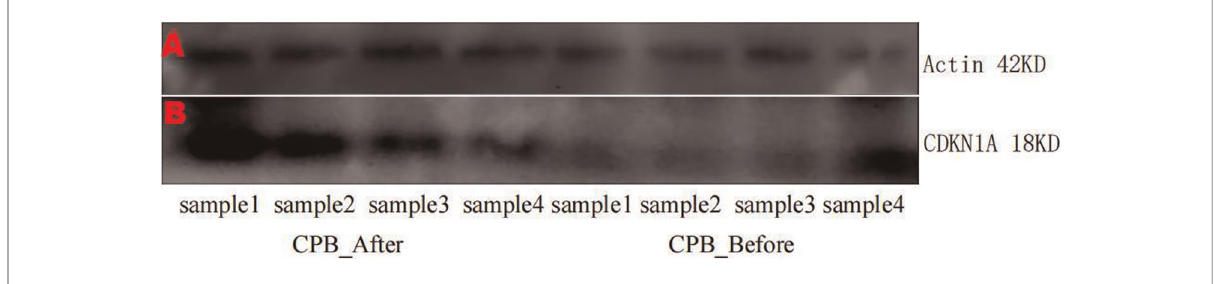
FIGURE 13 SDS-PAG electrophoregram. ( A ) β -actin ( B ) CDKN1A Line 1 – 4 are CPB-after samples, Line 5 – 8 CPB-before samples. Pictures of gels were cropped and juxtaposed and the full length gel pictures could be found in Supplementary Figures 1, 2